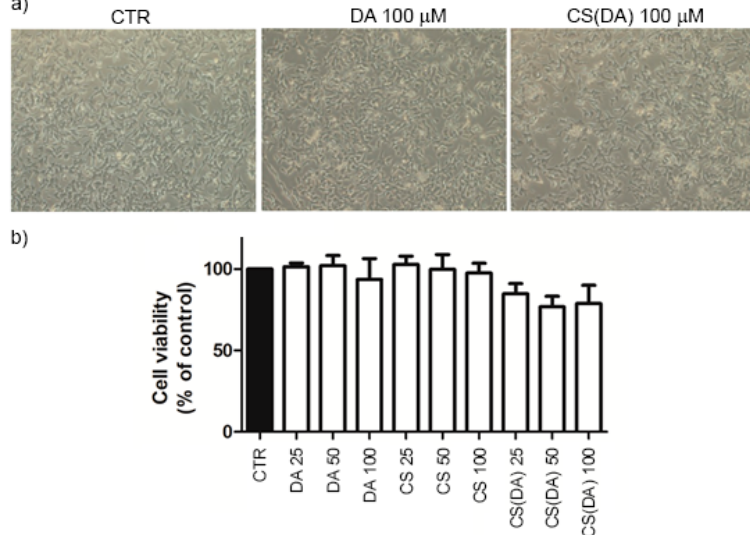
Figure 3. Dose-dependent effects of free DA and CS(DA) NPs on SH-SY5Y cell-viability. ( a ) Optical microscopy imaging of control cells (CTR), cells incubated with free DA (100 µM) and cells incubated with CS NPs loaded with the same amount of DA. ( b ) Histogram of cell viability after treatment with free DA, CS and CS(DA) NPs with respect to untreated control cells at 25, 50 and 100 µM DA concentration.